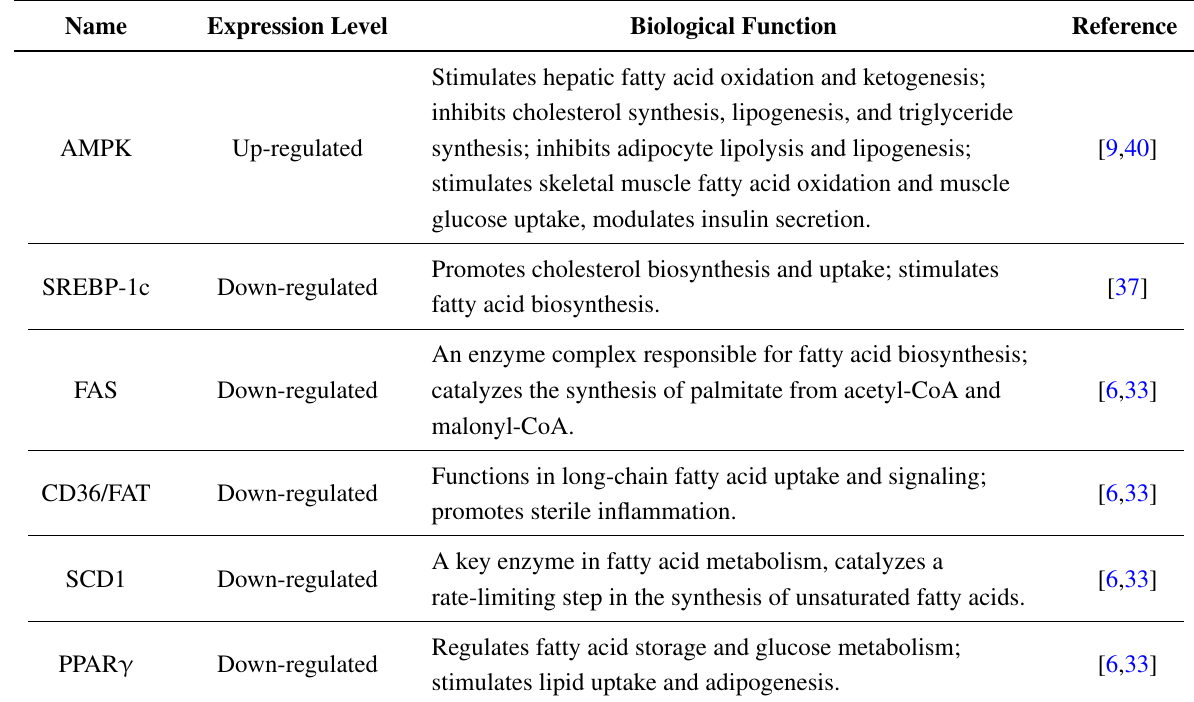
Table 2. The regulation of deficient PASK in mammalian lipid